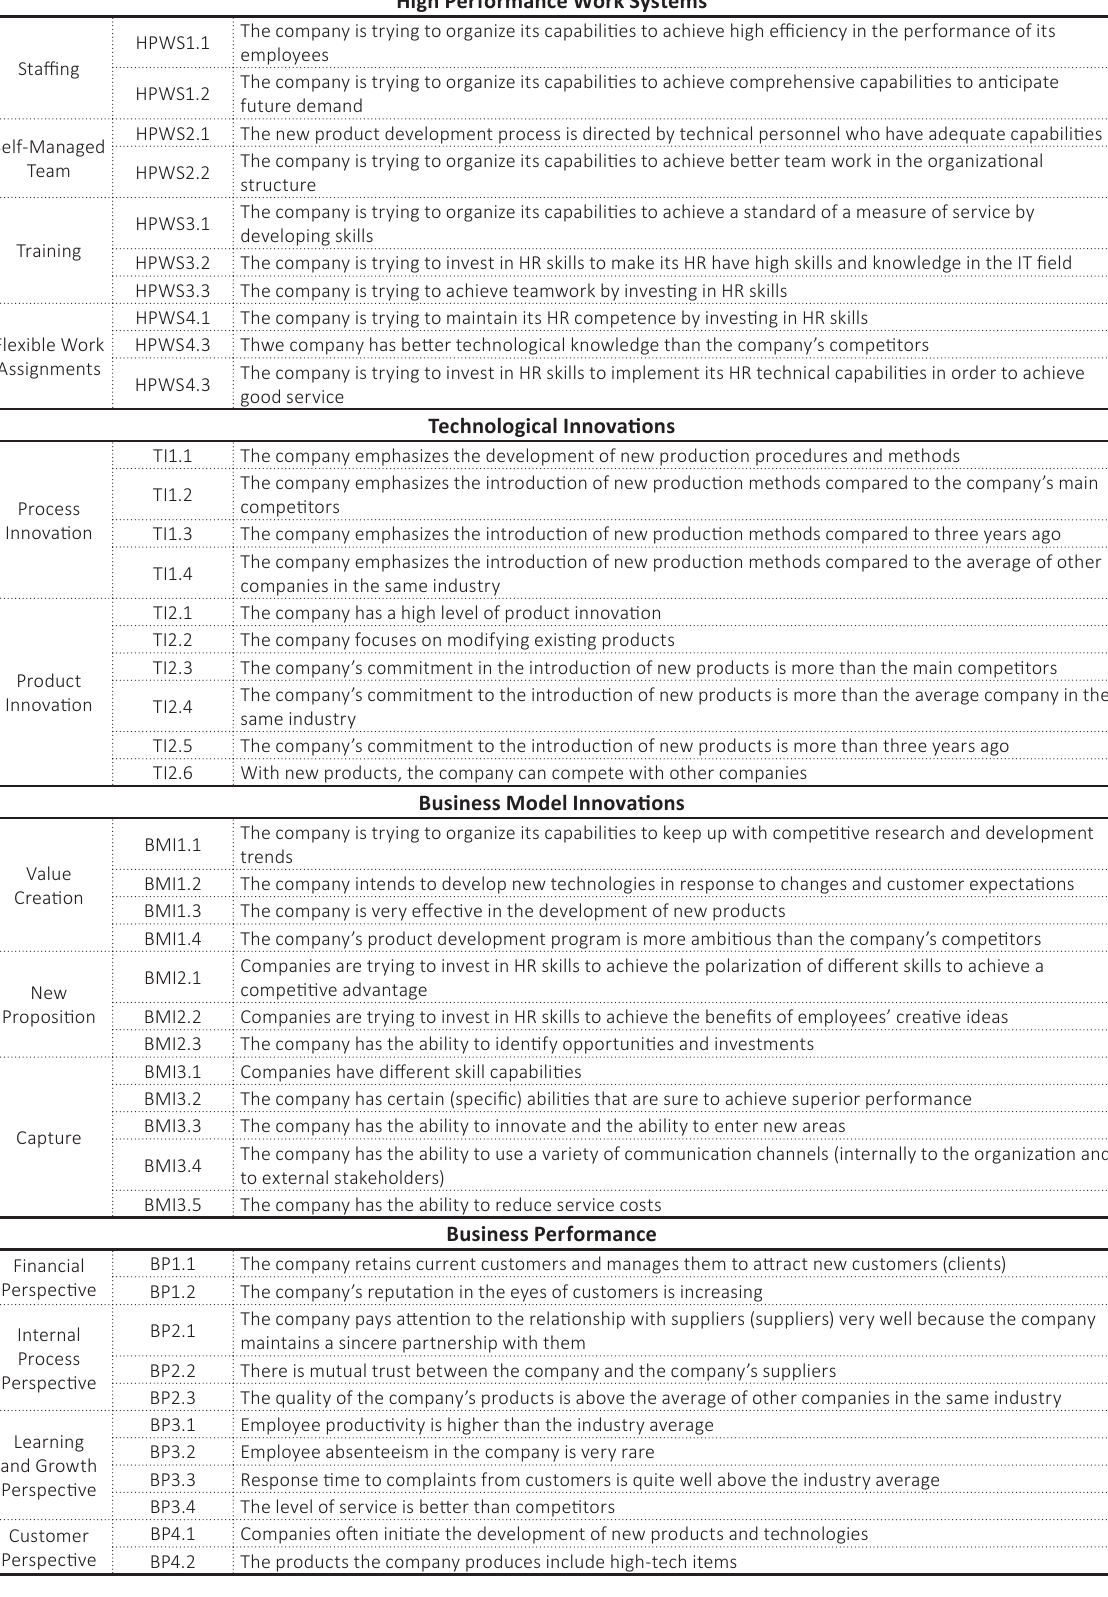
Table A1. Questionnaire Items (Translated from Indonesian to English) High Performance Work